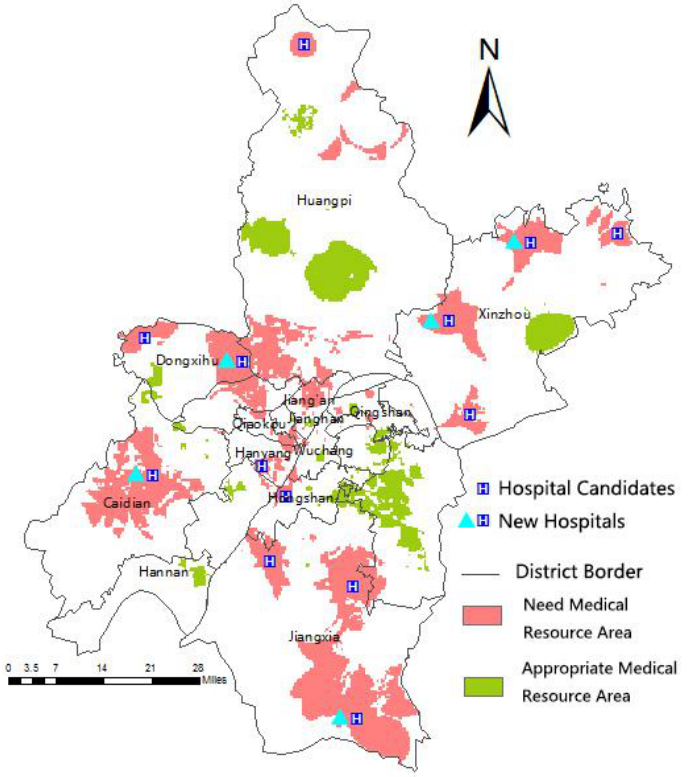
Figure 8. Removal of the non-building land location selection results.